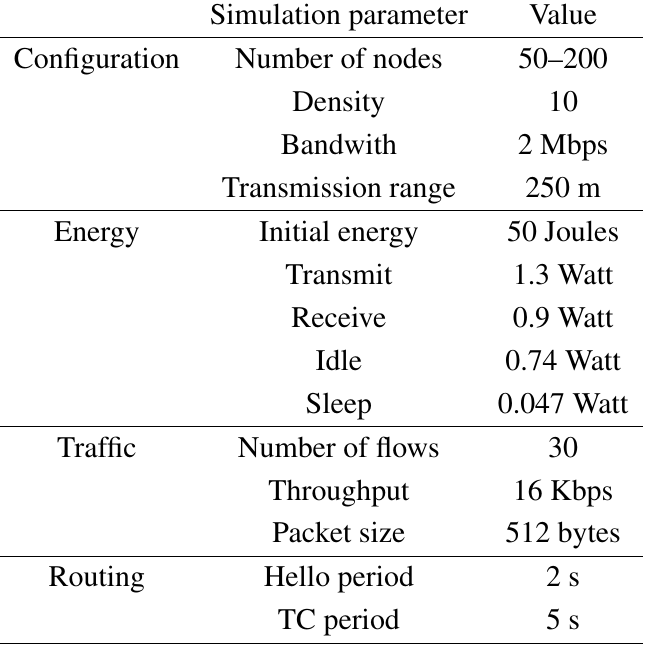
Table 2. Simulation parameters.